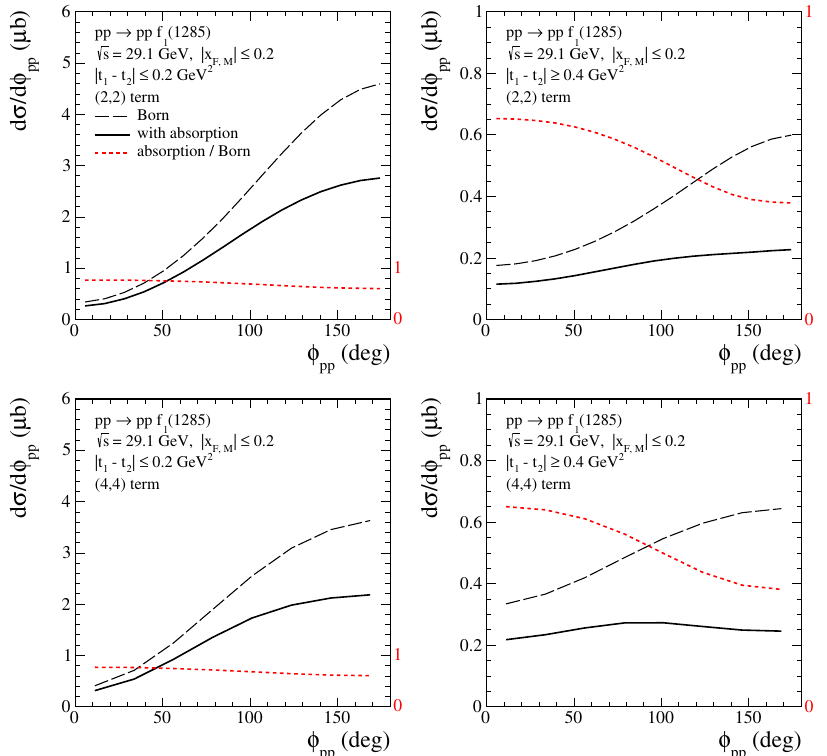
(cid:112) ( 1285 ) meson production at s = 29.1 GeV, Figure 3: The φ distributions for f pp 1 | x | (cid:182) 0.2, for | t − t | (cid:182) 0.2 GeV 2 (left) and for | t − t | (cid:190) 0.4 GeV 2 (right). F , M 1 2 1 2 The long-dashed black lines represent the Born results and the solid black lines cor- respond to the results with the absorption effects included. The dotted red lines represent the ratio of full and Born cross sections on the scale indicated by the red numbers on the r.h.s. of the panels.